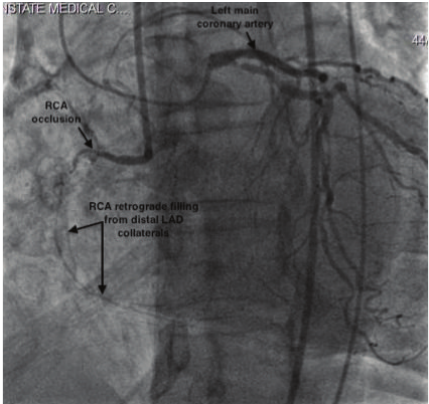
Figure 2: Diagnostic catheterization via simultaneous injection of the right and left coronary systems showing moderate collaterals from the distal LAD supplying the RCA and chronic total occlusion of the proximal